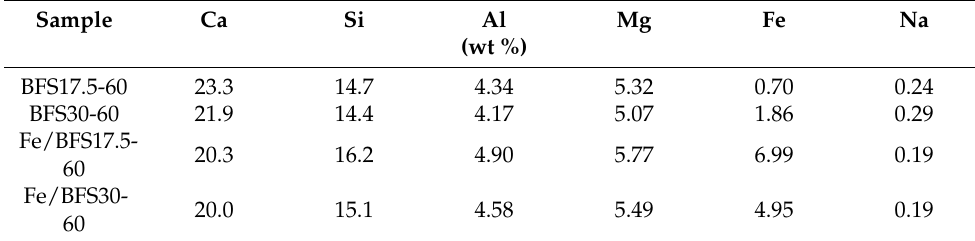
Table 4. Metal concentrations (as wt %) of selected samples, as determined by ICP-OES analysis.